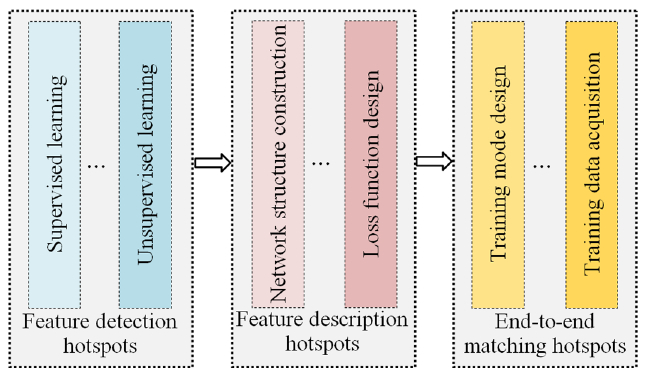
Figure 1. Focus of this review: Topics of deep-learning methods for wide-baseline stereo image matching.